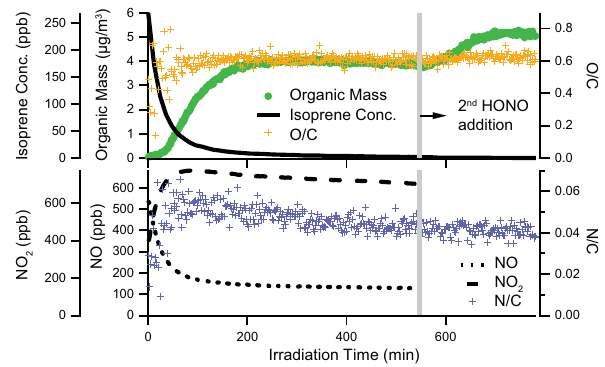
Fig. 7. Top panel: Time dependence of AMS organic mass (not corrected for collection efficiency), O/C ratio, and isoprene con- centration for Experiment 12. Bottom panel: Time dependence of NO, NO 2 , and N/C ratio for Experiment 12. A second addition of HONO at about 550 min after the start of the experiment is